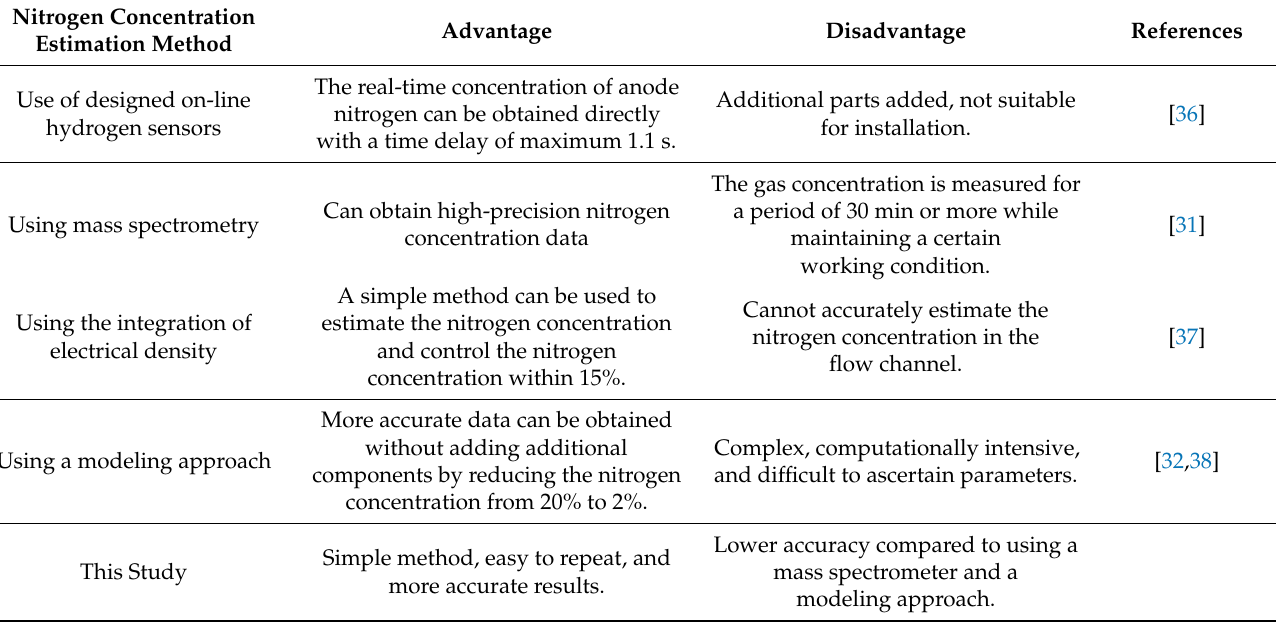
Table 3. Comparison of different nitrogen concentration estimation